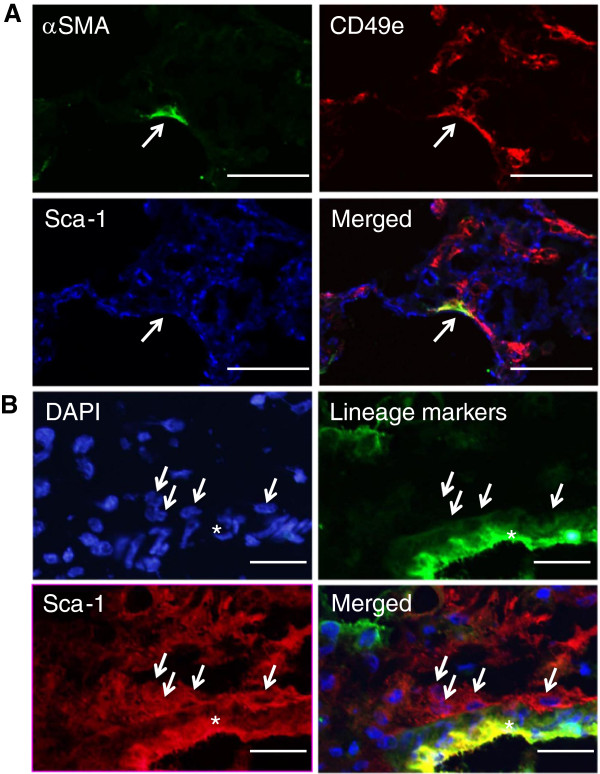
Exploring cell surface markers of myofibroblasts and fibroblasts. (A) Snap-frozen bleomycin-injured lungs at day 12 were fixed in acetone and examined by immunofluorescence using anti-α-SMA antibody (upper left), anti-CD49e antibody (upper right), and APC-conjugated anti-Sca-1 antibody (lower left); the three images were merged (lower right). Arrows indicate a myofibroblast. Figures show representative results. Scale bars indicate 100 μm. (B) Snap-frozen bleomycin-injured lungs at day 12 were fixed in acetone and examined by immunofluorescence with DAPI (upper left), FITC-conjugated antibodies to lineage-specific cell surface markers (CD31, CD45, EpCAM, TER119, CD146, and Lyve-1) (upper right), and PE-conjugated anti-Sca-1 antibody (lower left); the three images were merged (lower right). Arrows indicate cells that were localized in the adventitia of the pulmonary artery and that were negative for lineage-specific cell surface markers (upper right) but positive for Sca-1 (lower left). Figures show representative results. Scale bars indicate 50 μm. DAPI, 4′,6-diamidino-2-phenylindole.